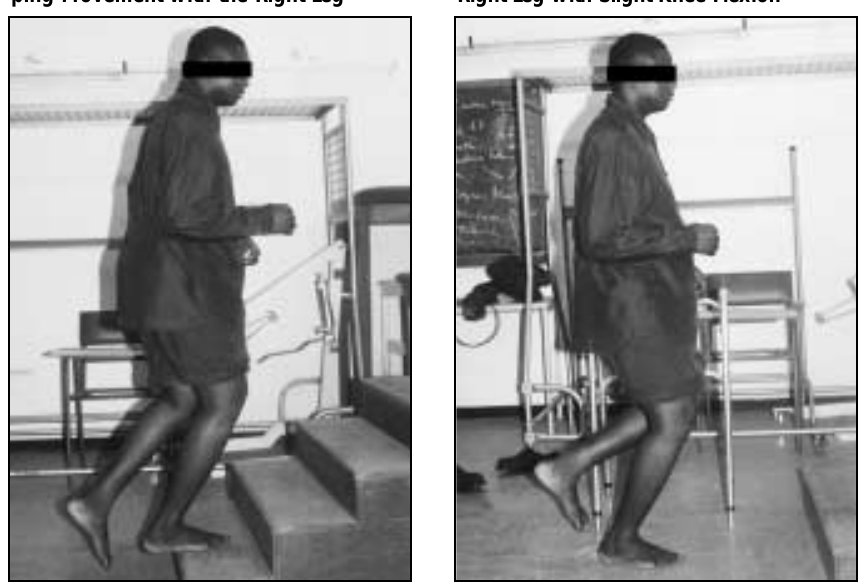
Figure 2: Patient in Full Weight Bearing on Right Leg with Slight Knee Flexion